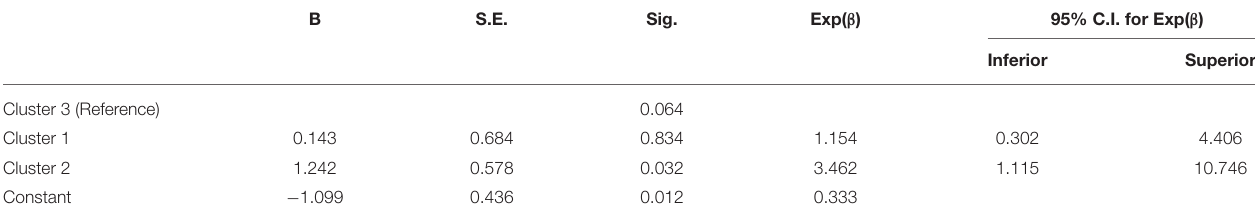
TABLE 3 | Unconditional logistic regression exploring the independent association of clusters categorization and survival risk. B